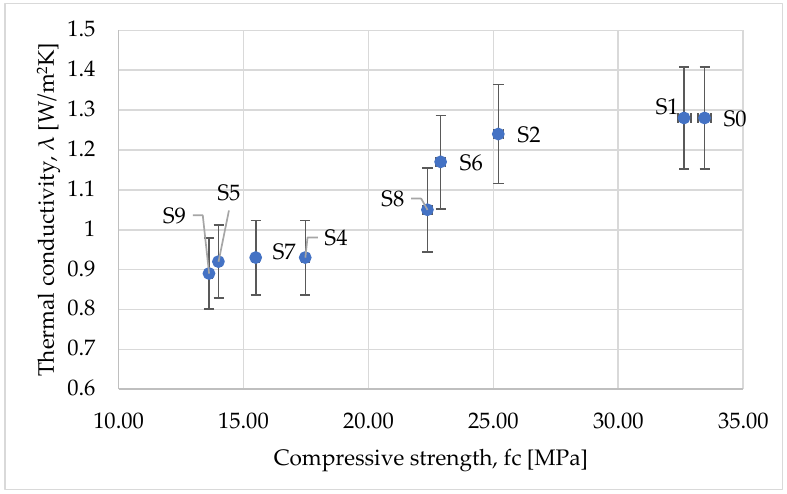
Figure 12. Variation of compressive strength versus density. From Figure 12, one can notice the existence of three zones: